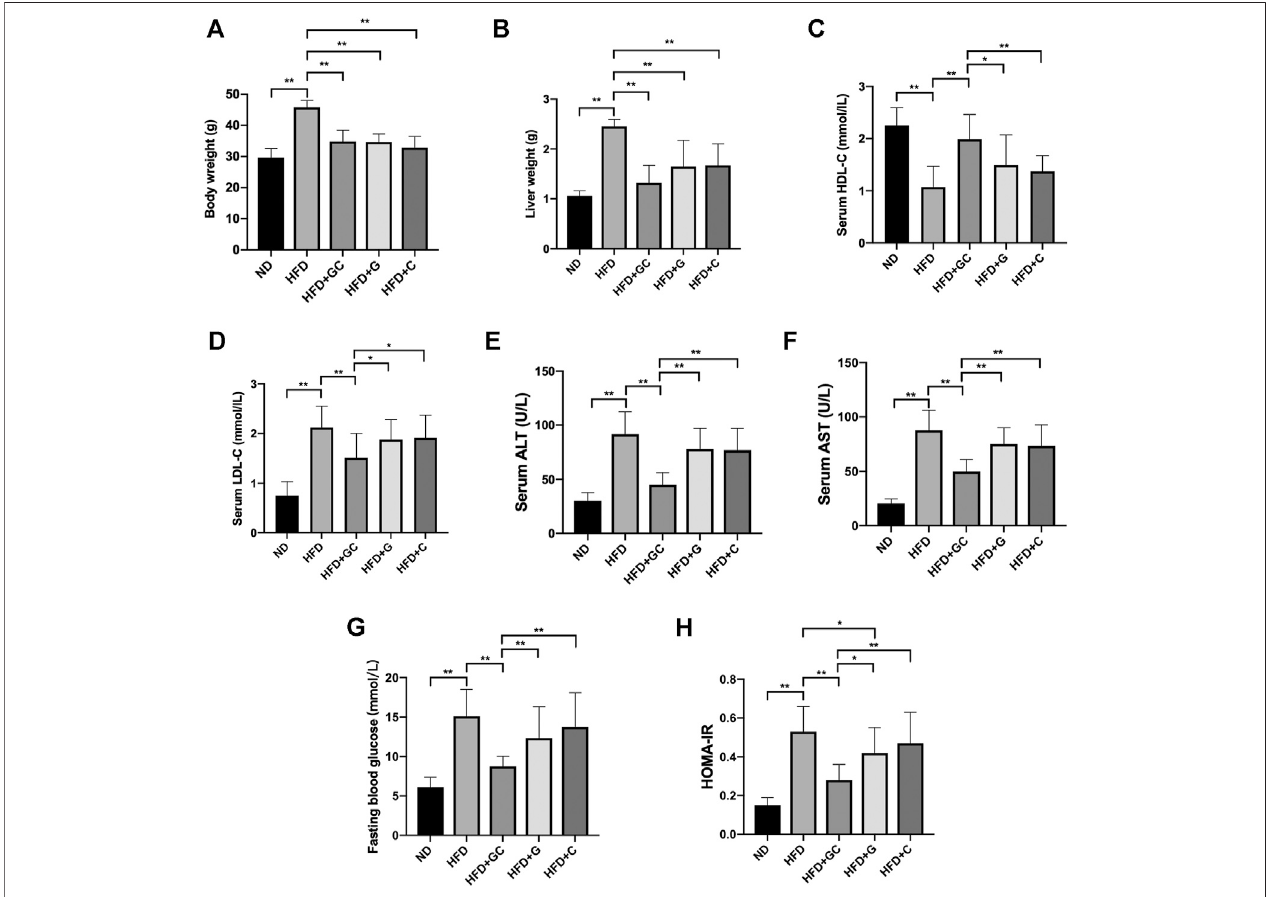
FIGURE 2 | The GC combination reverses biochemical parameters in NAFL mice. The mice body weight (A) , liver weight (B) . The level of serum HDL-C (C) and LDL-C (D) , serum ALT (E) and AST (F) , fasting blood glucose (G) , and HOMA-IR (H) in the mice from each group ( n (cid:1) 10). * p < 0.05, ** p < 0.01.